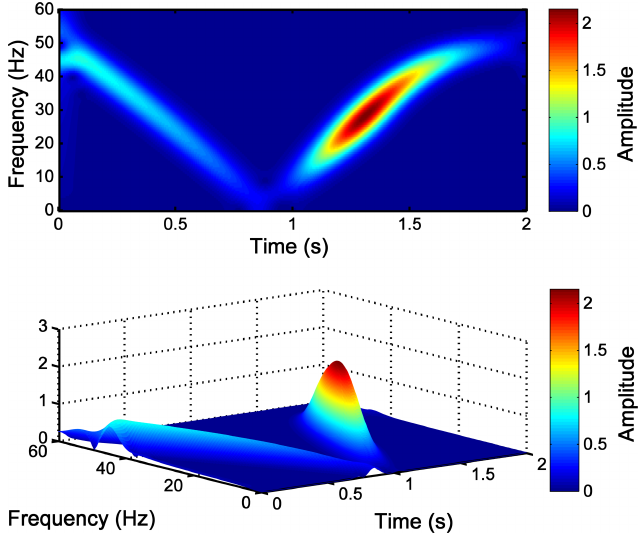
Figure 8. Time-frequency-amplitude pattern generated by the LSH obtained with the optimized Slepian window ( B W = 20.85 Hz, T W = 383.7 ms), as a 2D view ( top ) and as a 3D view ( bottom ).